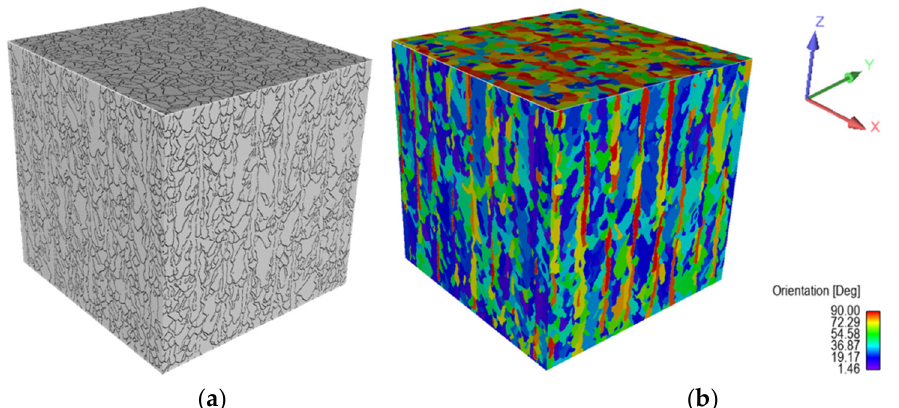
Figure 13. Simulated cube with an edge length of 0.5 mm showing ( a ) the grain boundaries and ( b ) the grain orientation.